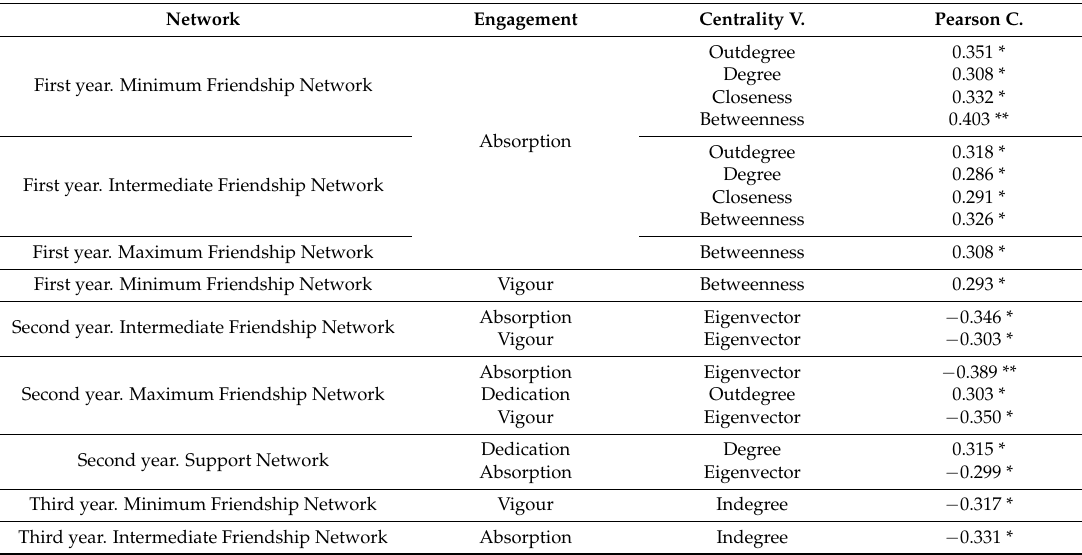
Table 4. Correlations between engagement and centrality variables.